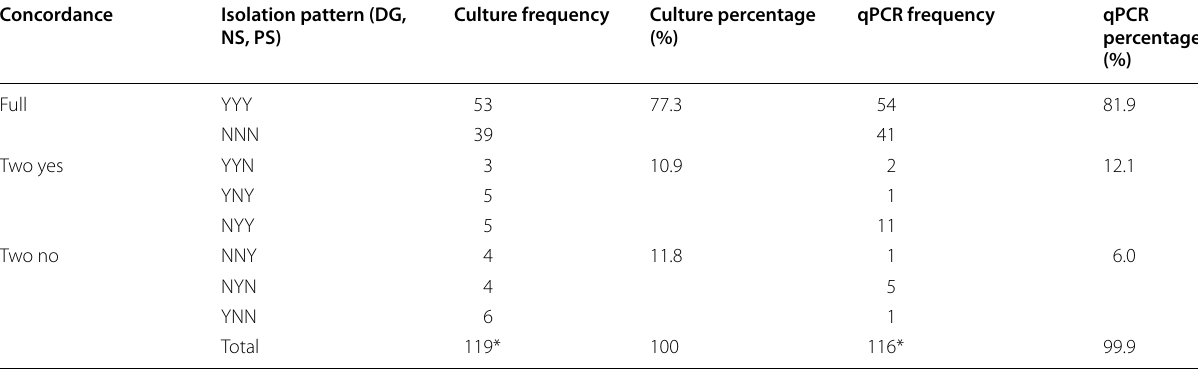
Percentage is out of total swabs with results from all 3 swab types *Samples from 1 swab for culture (DG) and 4 swabs for qPCR (3 DG and 1 PS) were damaged in transport or failed DNA extraction so samples from these animals were not used in concordance analysis. DG double-guarded swab, NS nasal swab, PS proctology swab, Y culture/qPCR positive, N culture/qPCR negative